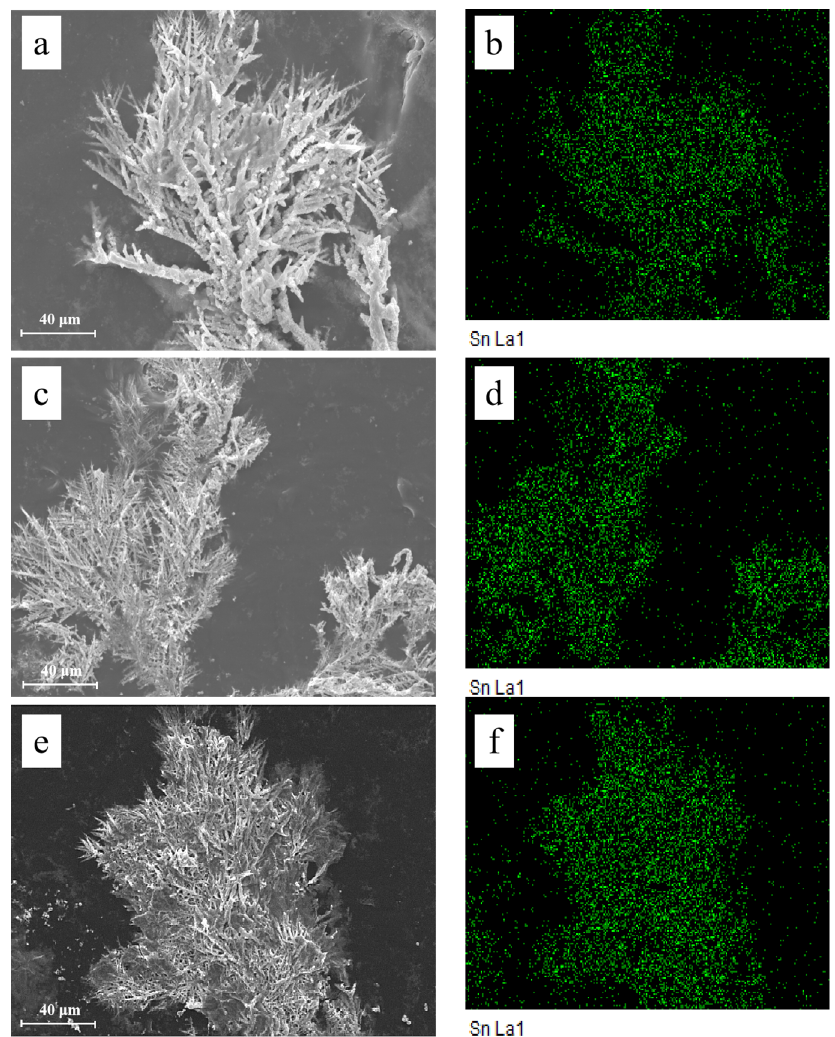
Figure 9. SEM images and corresponding EDS results of dendrites formed after ECM tests of tin under a droplet of 15 µ L containing various concentrations of Na 2 HPO 4 at 3 V: ( a ) 0 mg / L; ( b ) EDS-Mapping results of image ( a ); ( c ) 50 mg / L; ( d ) EDS-Mapping results of image ( c ); ( e ) 100 mg / L; ( f ) EDS-Mapping results of image ( e ).